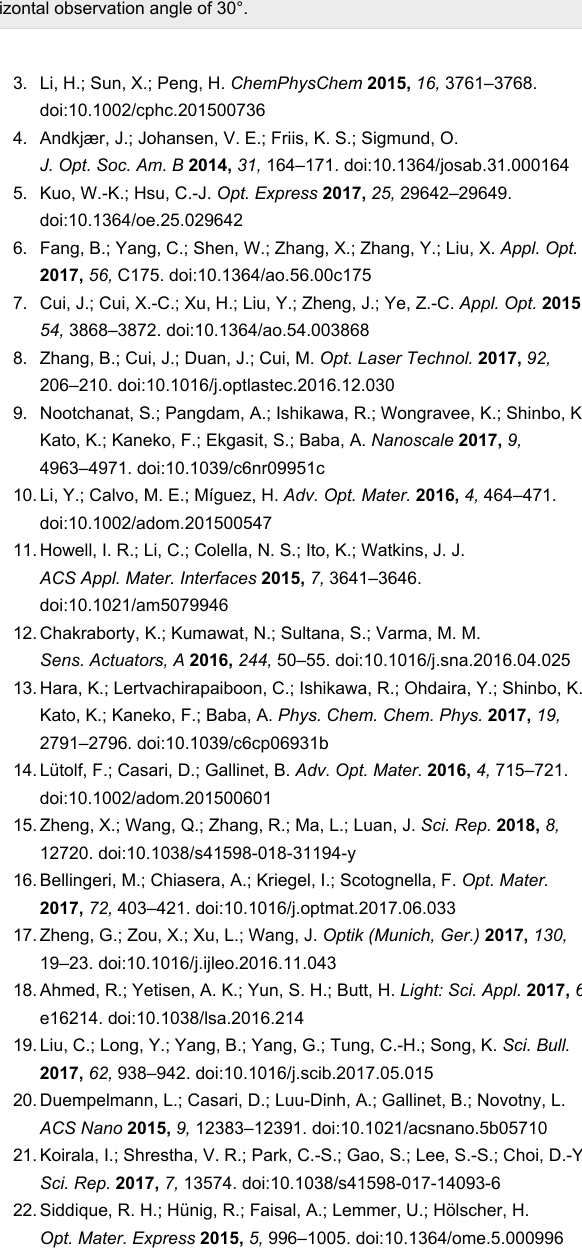
Figure 6: (a) Reflection wavelength peak as a function of the horizontal observation angle under a vertical observation angle of 45°. (b) Reflection wavelength peak as a function of the vertical observation angle under a horizontal observation angle of 30°.